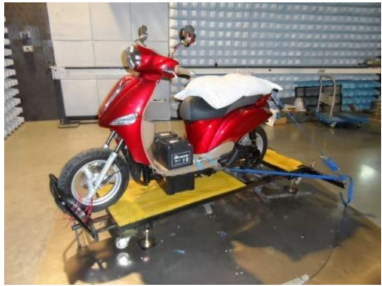
Figure 22. EMI/EMC testing of the constructed electric